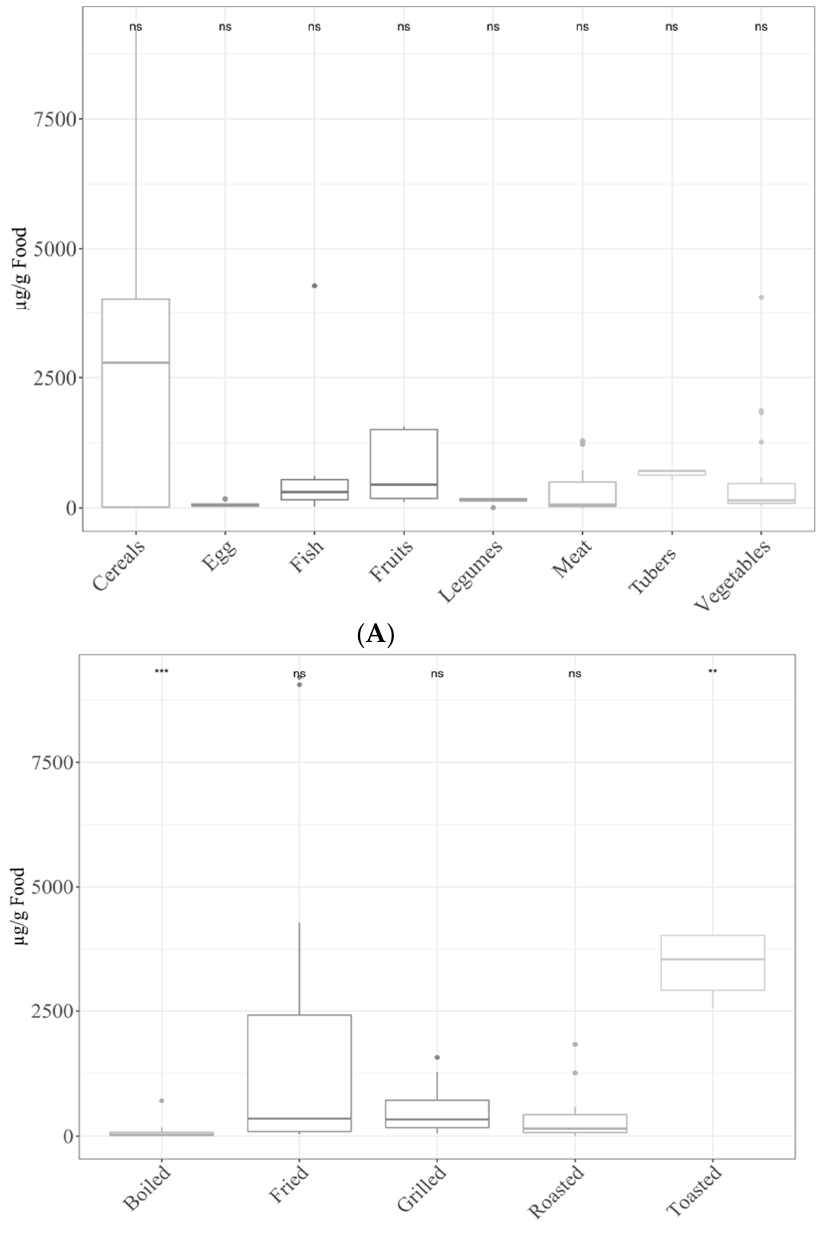
Figure 2. ( A ) HMF levels in different food groups. Statical analysis was performed via Kruskal–Wallis test. Each of the groups were compared to the average of all of them (i.e., base-mean). Statistic labels: ns: not significant. ( B ) HMF levels depending on the cooking applied. Statical analysis was performed via Kruskal–Wallis test. Each group was compared to the average of all of them (i.e., base-mean). Statistic labels: **: p < 0.01, ***: p < 0.001, ns: not significant.